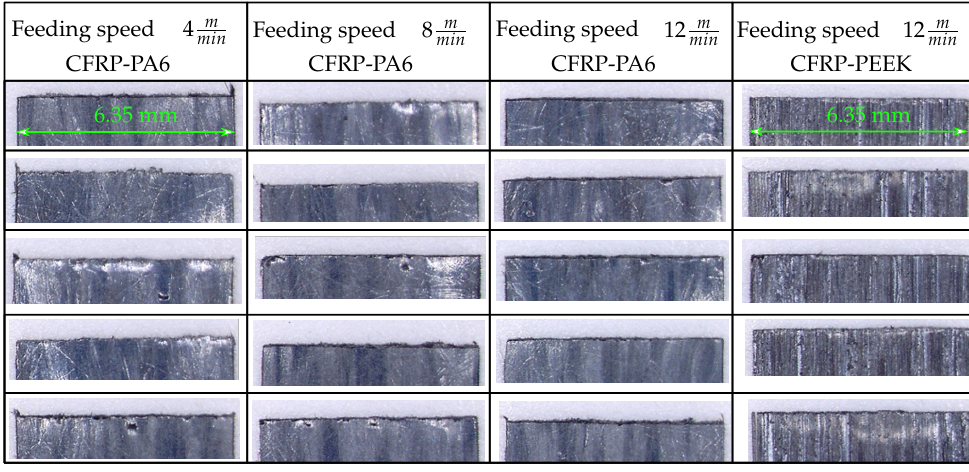
Figure 9. Microscopic view of the cutting edge in relation to the feed speed (cut on